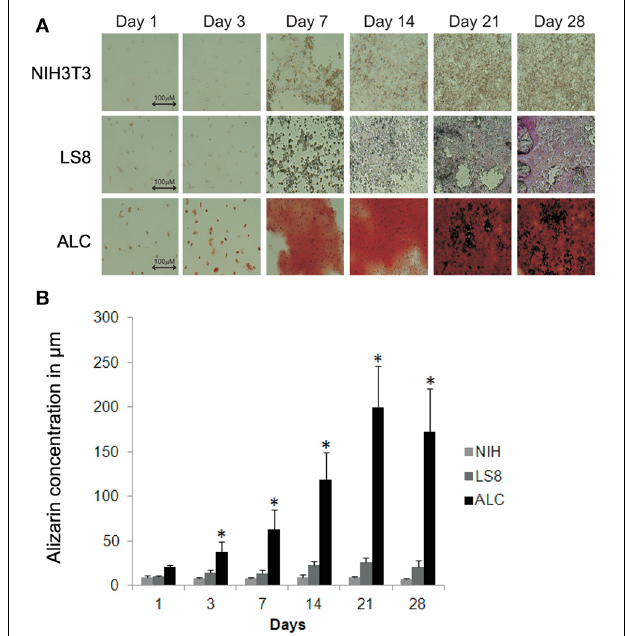
FIGURE 3 | Biomineralization assay for ALC and LS8 cells. (A) Alizarin Red staining was detected at levels significantly higher than background at day 3 post inoculation, and this is characteristic of calcified nodule formation. In ALC cells, stain accumulation increased over a period of 21 days, with no significant change beyond 21-days. Only background level staining was observed in LS8 cells, when compared to NIH3T3 cells (negative control) at day 1 and also over this same time period. Scale bar 100.0 μ m. (B) Alizarin Red stain in NIH3T3, LS8, and ALC cell culture were quantified using Osteogenesis quantification kit at OD 405 . Graph shows significant increase in red staining in ALC cells only. Significance indicated by ∗ for p < 0 . 05 for differences in individual cell